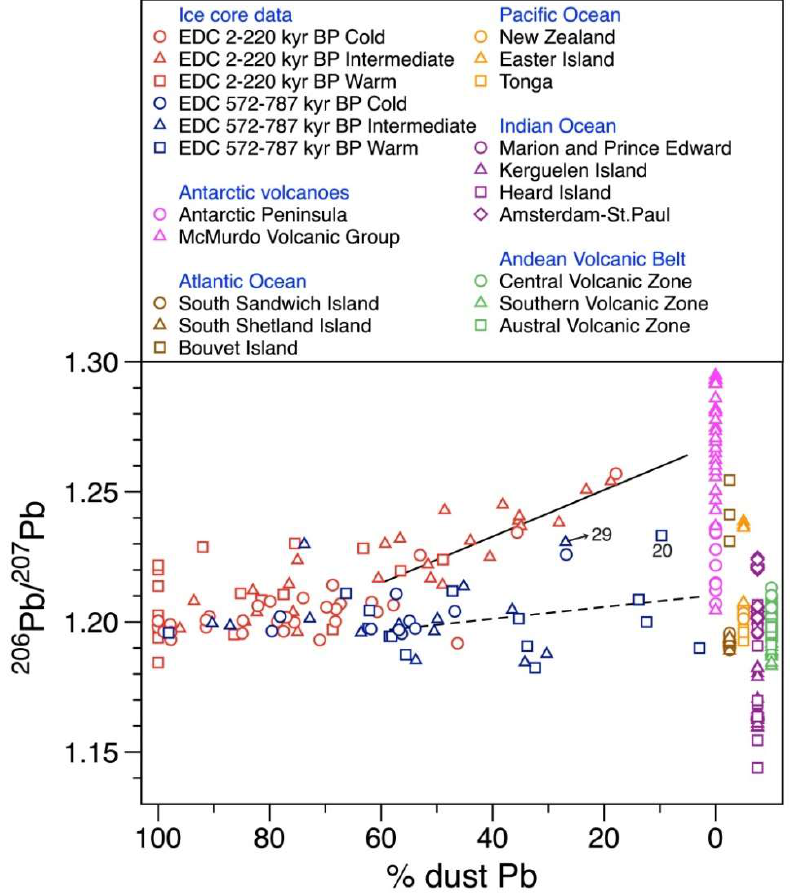
Figure 4. Comparison of 206 Pb/ 207 Pb ratios between the pre-MBE and post-MBE intervals as a function of the dust fraction of Pb in the EDC ice core samples. All uncertainties are 95% confidence intervals. The end-members of volcanic 206 Pb/ 207 Pb ratios for the potential volcanic sources come from published literature: Antarctic Peninsula basalts [67], McMurdo Volcanic Group [35,36], South Sandwich Island [37], South Shetland Island [38], Bouvet Island [39], New Zealand [40], Easter Island and Tonga [39], Marion and Prince Edward [41], Kerguelen Island [42], Heard Island [43], Amsterdam-St. Paul Island [44], and Andean Volcanic Belt [45,46]. The locations of individual volcanoes are shown in Figure S2. Note that the fraction of dust Pb in excess of 100% shown in part of the post-MBE samples [17] was considered to be 100%. The least squares lines are shown for the post-MBE (solid line) (Spearman’s correlation of 0.736 at p < 0.01) and pre-MBE (dashed line) isotopic data (no correlation with Spearman’s correlation of 0.207) with a dust-derived Pb fraction of < 60%. Sample numbers mentioned in the text are also shown in Figure 4.